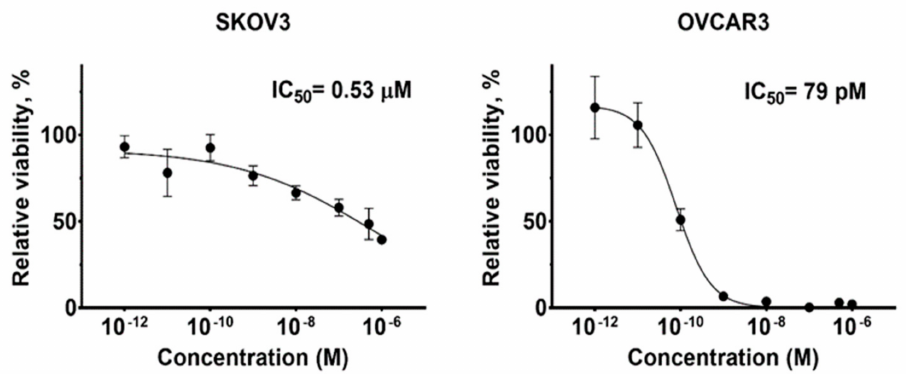
Figure 5. Cytotoxicity of Ec1-LoPE in EpCAM-expressing SKOV3 and OVCAR3 cell lines. The cells were incubated with dilution series of the Ec1-LoPE DARPin-toxin (0–1000 nM). The viability of cells grown in media without the toxin was used as 100% viability control. The viability curve is plotted with relative viability as y -axis and concentration of Ec1-LoPE as x -axis. The data are presented as average ± SD ( n = 4 −